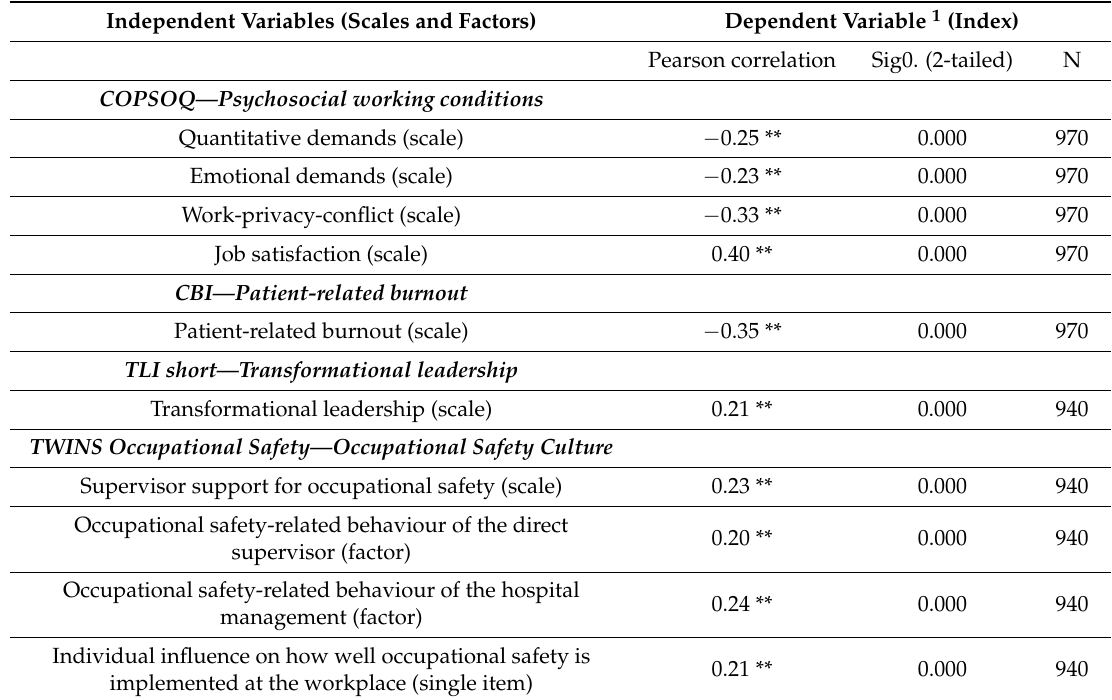
Table 4. Occupational Safety Culture model—correlations of independent variables and the outcome “personal perception of the frequency of occupational risks”.